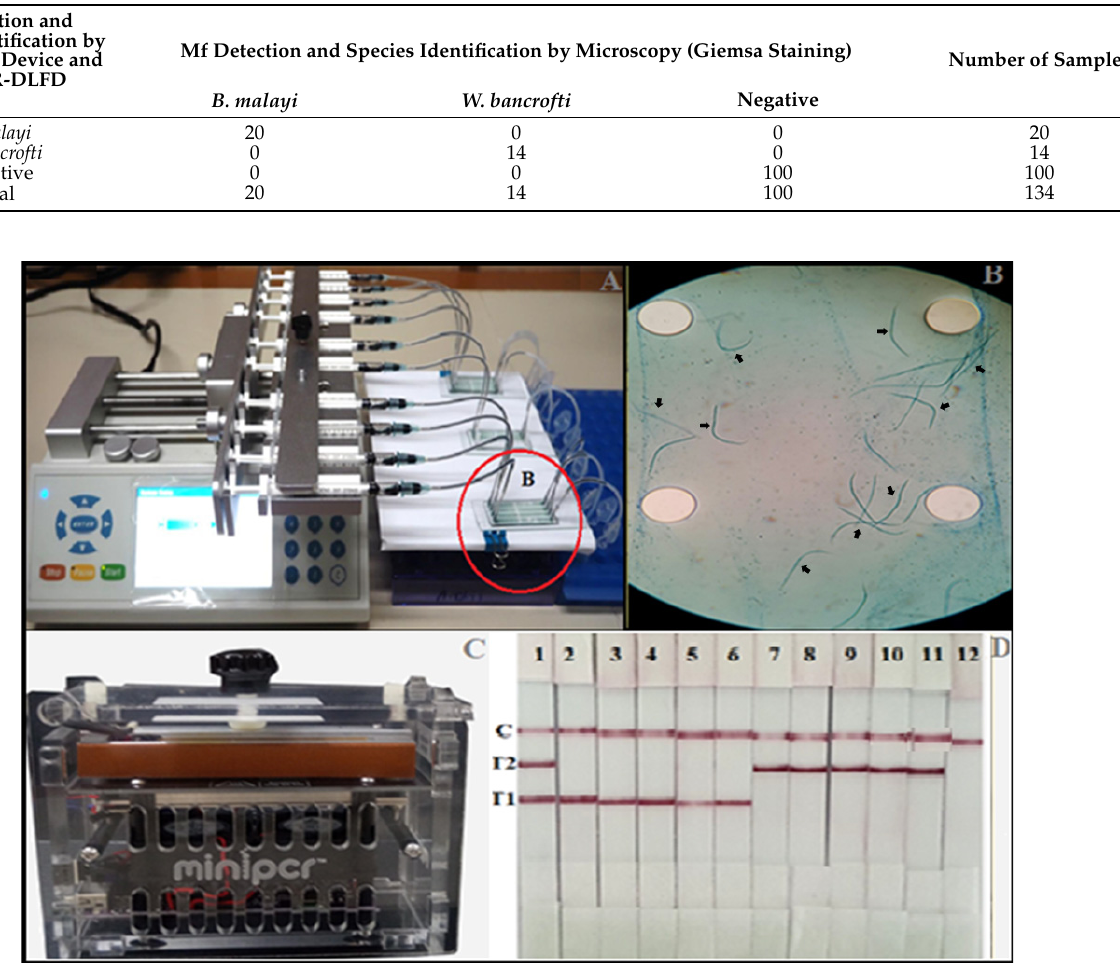
Table 1. Microfilaria detection and species identification in 134 human blood samples using the microfluidic device-iminiPCR-DLFD platform and microscopy.